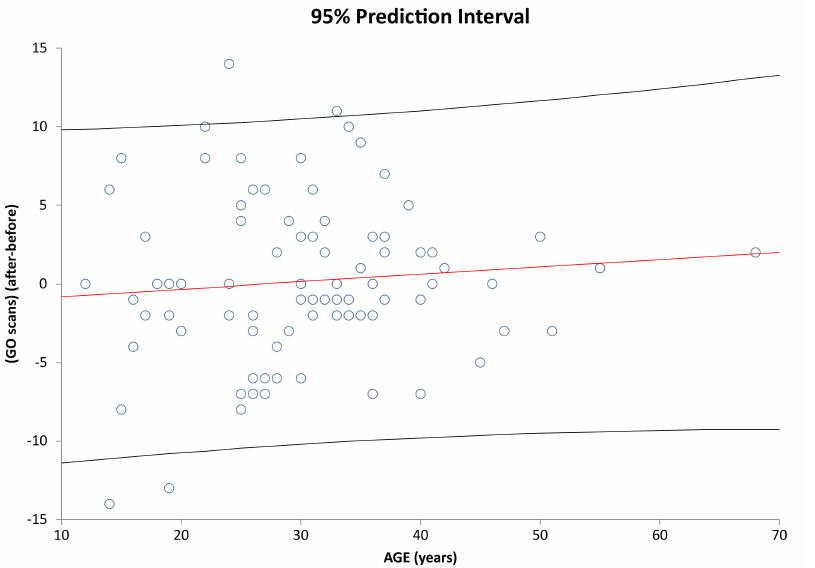
Figure 10. Prediction interval and linear regression line for Age vs. GO scans change (After-Before) vs. Age in the investigated sample (r = 0.0507; p = 0.6433). Regression line and 95% prediction interval are denoted as in Figure 7. Coefficient (r) = 0.089831 p = 0.4108. The influence of gender and differences in individual parameters before vs after and their statistical significance (evaluated by Wilcoxon signed-rank test) is in the Table 2